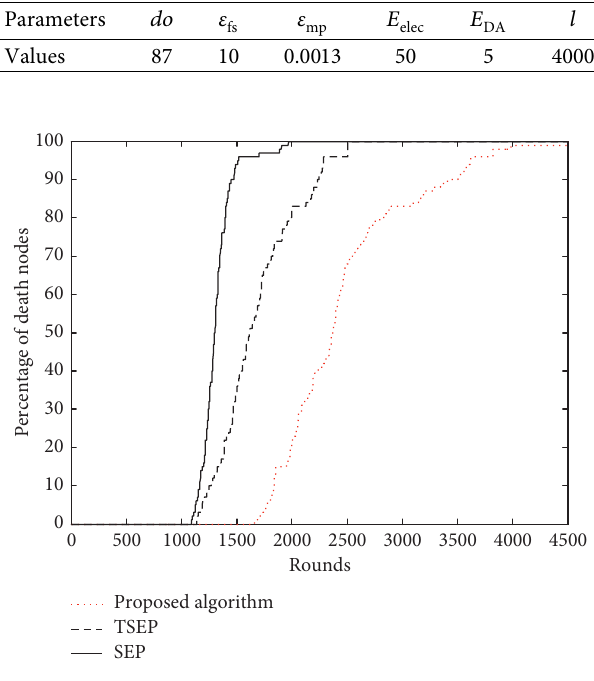
Figure 2: Flow chart of our proposed algorithm. Table 1: The simulation parameters of the experiment.